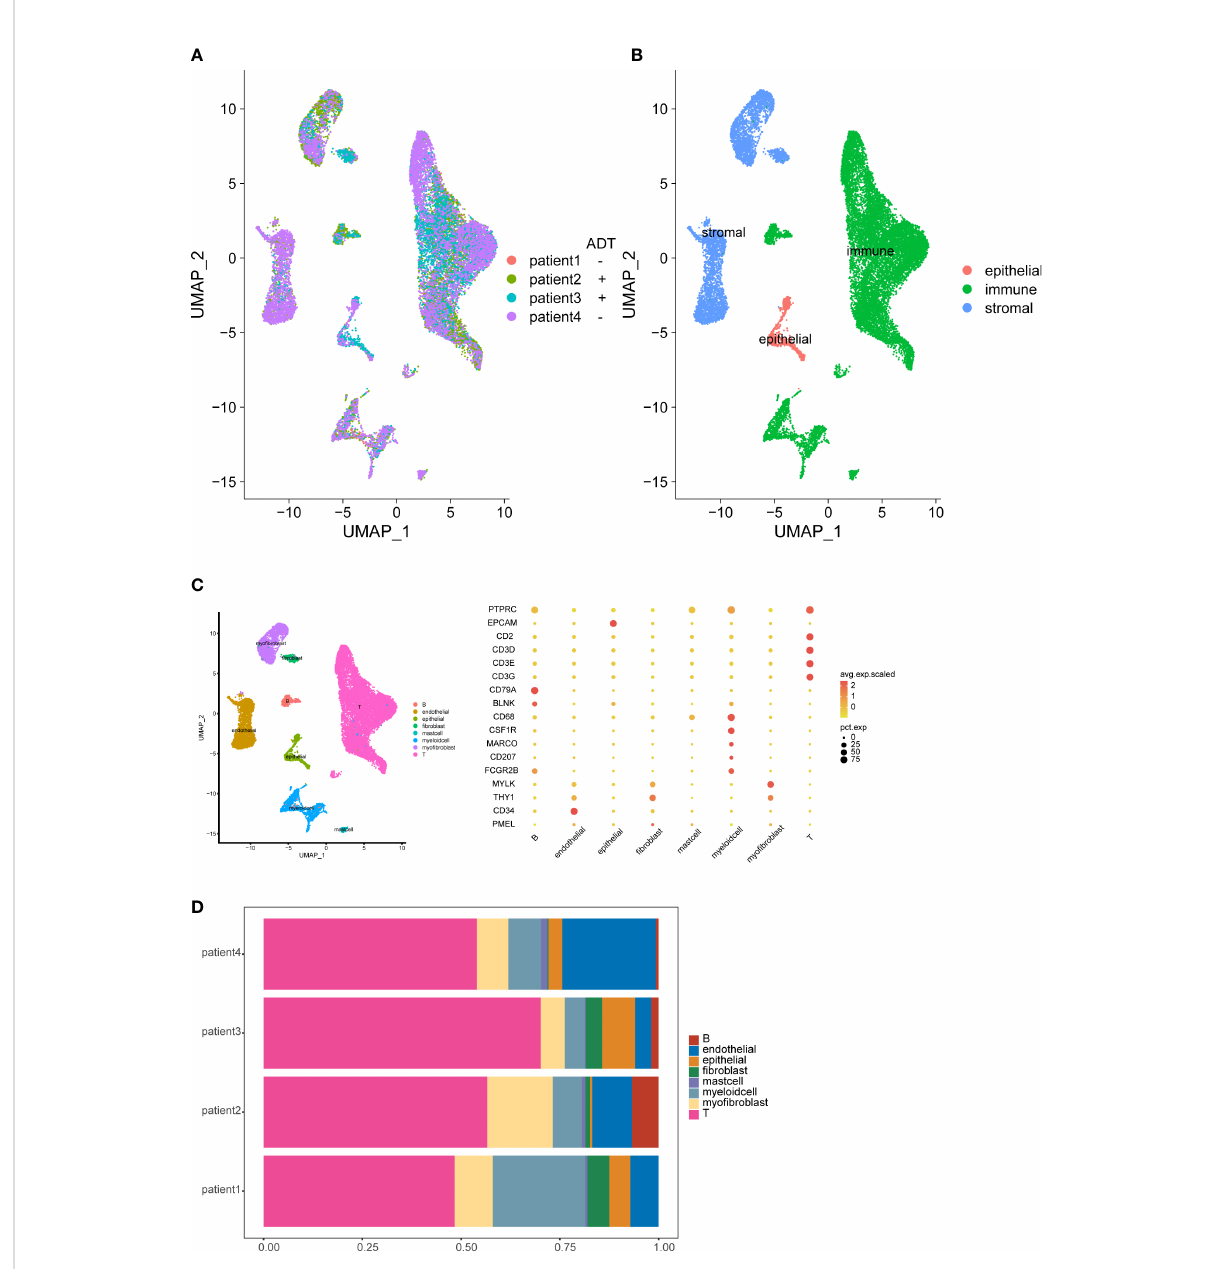
FIGURE 1 Overview of the single-cell landscape for prostate cancer. UMAPs of all single-cell transcriptomes after fi ltering, color-coded by patient (A) and quanti fi cation of main cell types per patient and UMAP of all single-cell transcriptomes color-coded by main cell type (B) . UMAPs of all single- cell transcriptomes color-coded by cell cluster; Marker gene expression for each cell type, where dot size and color represent percentage of marker gene expression (pct. exp) and the averaged scaled expression (avg. exp. scale) value, respectively (C) . Cell composition distribution for each patient sample (D)